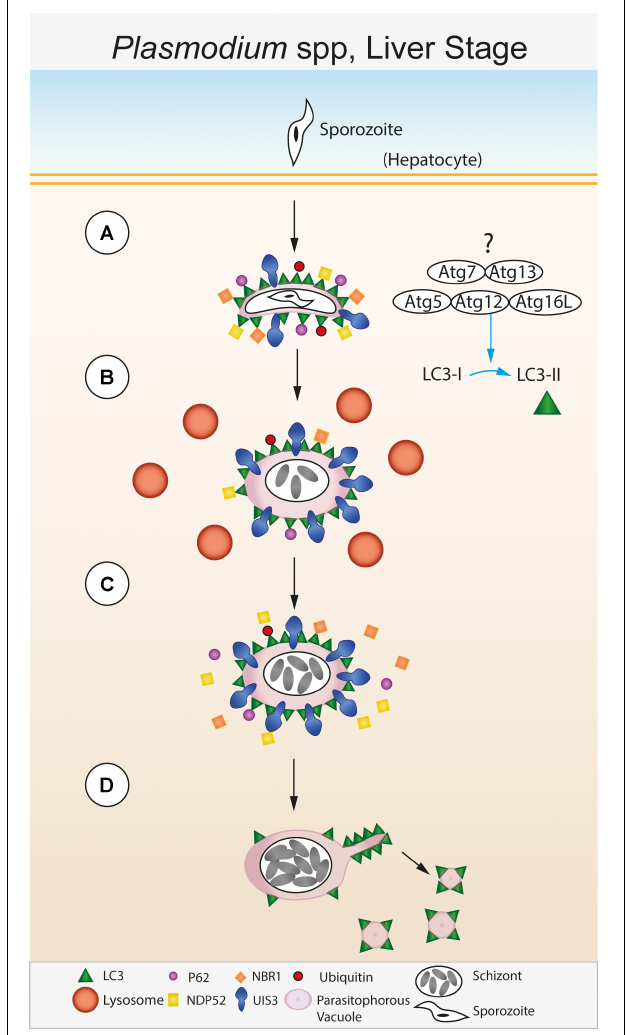
FIGURE 2 | Autophagic control of the liver stage of Plasmodium spp. (A) The sporozoite stage of the Plasmodium parasite invades a hepatocyte within the liver. Following invasion, the parasite resides within a membrane bound parasitophorous vacuole (PV) within the host cell cytosol (Meis et al., 1983; Lingelbach and Joiner, 1998; Nyboer et al., 2017). The PV membrane (PVM) is recognized immediately after infection by the host. Lipidated LC3 is deposited onto the PVM followed by recruitment of host effector proteins including p62, NDP52, NBR1, and ubiquitin (Schmuckli-Maurer et al., 2017). (B) The Plasmodium PVM resident protein UIS3 sequesters LC3 at the PVM surface and prevents further p62/NDP52/NBR1/ubiquitin binding (Real et al., 2018). Meanwhile, the PVM is surrounded by lysosomes, however, lysosomal fusion and acidification of the PVM compartment does not occur. (C) This step is required for parasite development within the host cell and leads to further schizont replication. (D) During late stage parasite development, LC3 is shed from the PVM via sequestration by the Plasmodium tubo-vesicular network (TVN) and subsequent scission from the PVM (Agop-Nersesian et al.,